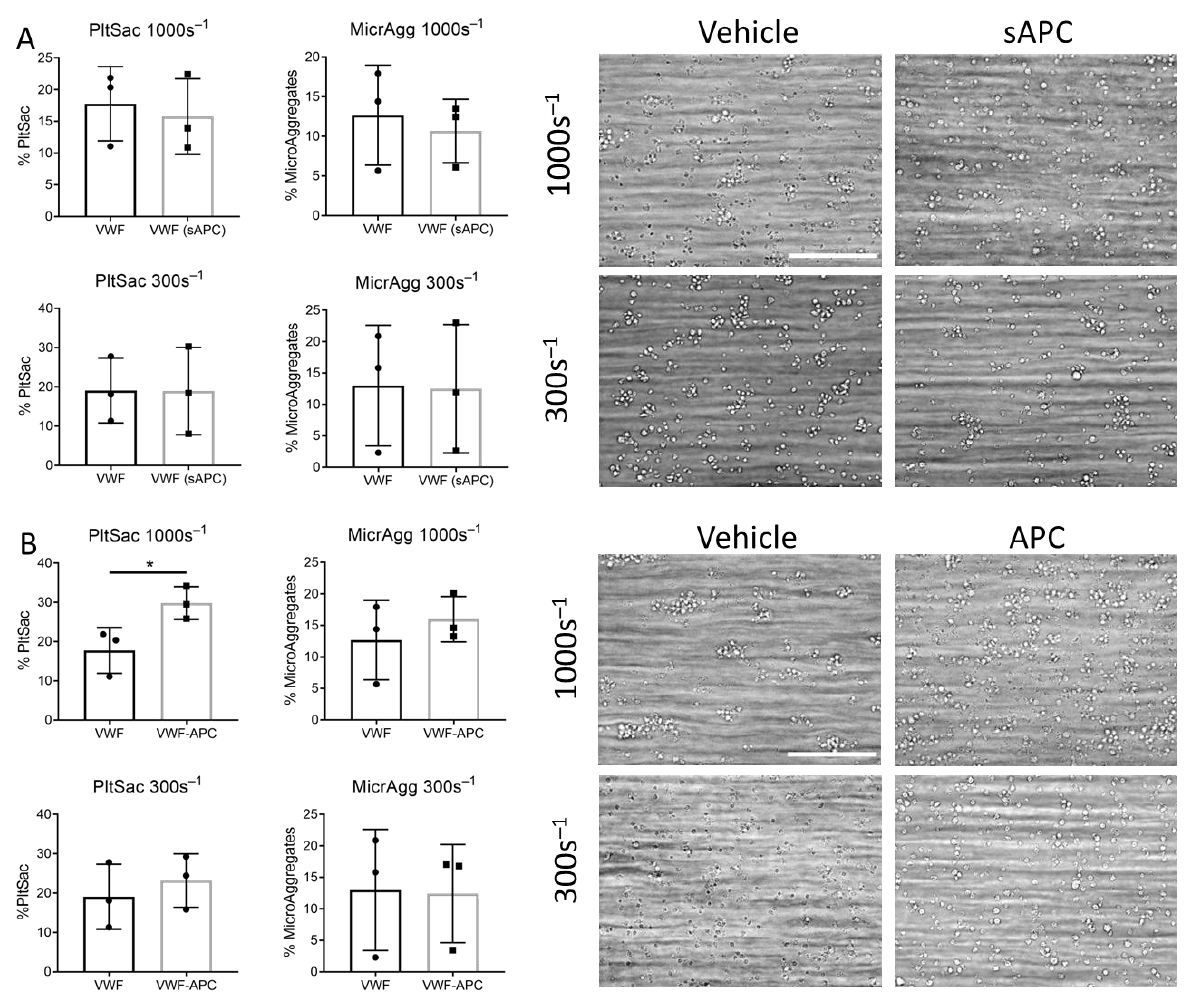
Figure 7. Immobilized APC enhances platelet adhesion on VWF. ( A ) Blood samples were preincubated for 5 min with APC (10 nM) and perfused over a surface coated with VWF. ( B ) Blood samples were perfused over surfaces coated with VWF ± APC. Wall shear rate was 300 s − 1 or 1000 s − 1 . Representative brightfield images (bars, 40 µm). Platelet adhesion (expressed as percentage surface area coverage, %PltSac). Platelets forming (micro)aggregates (expressed as percentage microaggregates, %MicrAgg). Unpaired t -test, * p < 0.05, mean ± SD, n = 3.